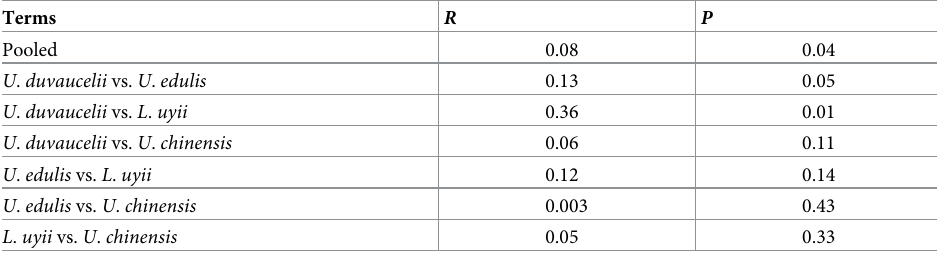
Table 4. Results of the analysis of similarities (ANOSIM) for the fatty acid composition among Uroteuthis duvau- celii , Uroteuthis edulis , Uroteuthis chinensis and Loliolus uyii in the northern South China Sea.